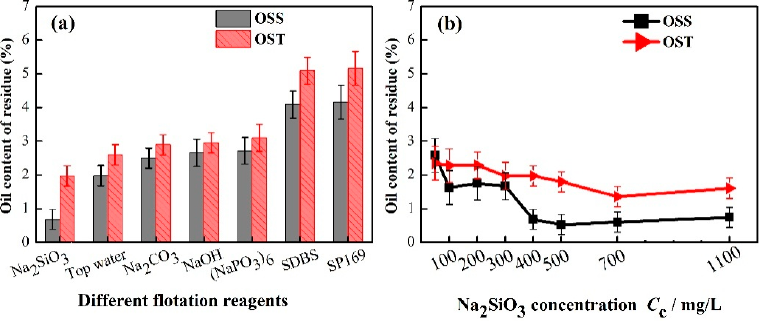
Figure 2. The oil content of residue changing with ( a ) flotation reagents and ( b ) Na 2 SiO 3 concentrations. Data plotted as mean of duplicates and the error bars indicate data reproducibility. Flotation conditions: C c = 400 mg/L, T t = 25 min, T p = 33 °C, R s = 1340 r/min, L/OS = 12:1.